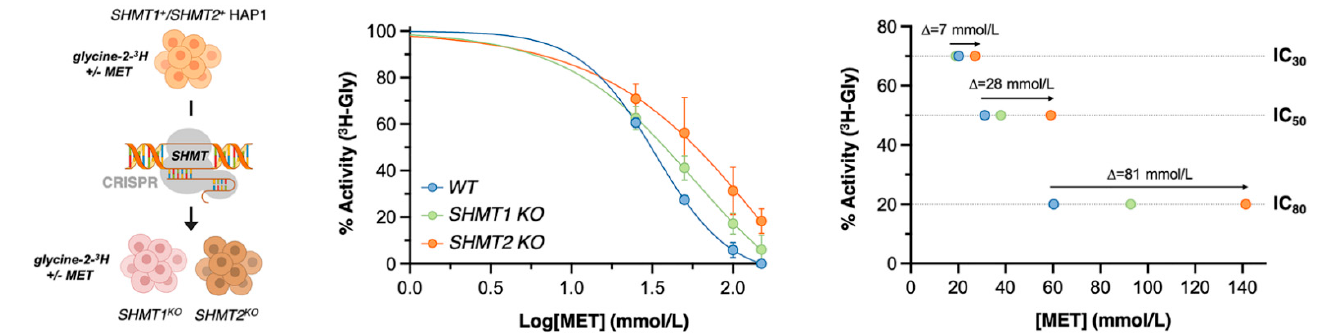
Figure 4. Metformin selectively inhibits SHMT2 activity in cancer cells. Suspensions of SHMT1 + /SHMT2 + HAP1 parental cells and SHMT1/SHMT2 KO-HAP1 derivatives were incubated with graded concentrations of metformin (MET, 0–150 mmol/L) for 1.5 h before adding the glycine radioisotope glycine-2- 3 H. Left. The results describe the dose-dependent effect of MET on the ability of SHMT to catalyze the exchange of glycine 2-pro-S proton with the solvent. Right. The inhibitory effect of MET on SHMT activity occurred in a dose-dependent manner but the IC 30 , IC 50 , and IC 80 curves were shifted to the right (less potent) in SHMT2 KO-HAP1 cells.